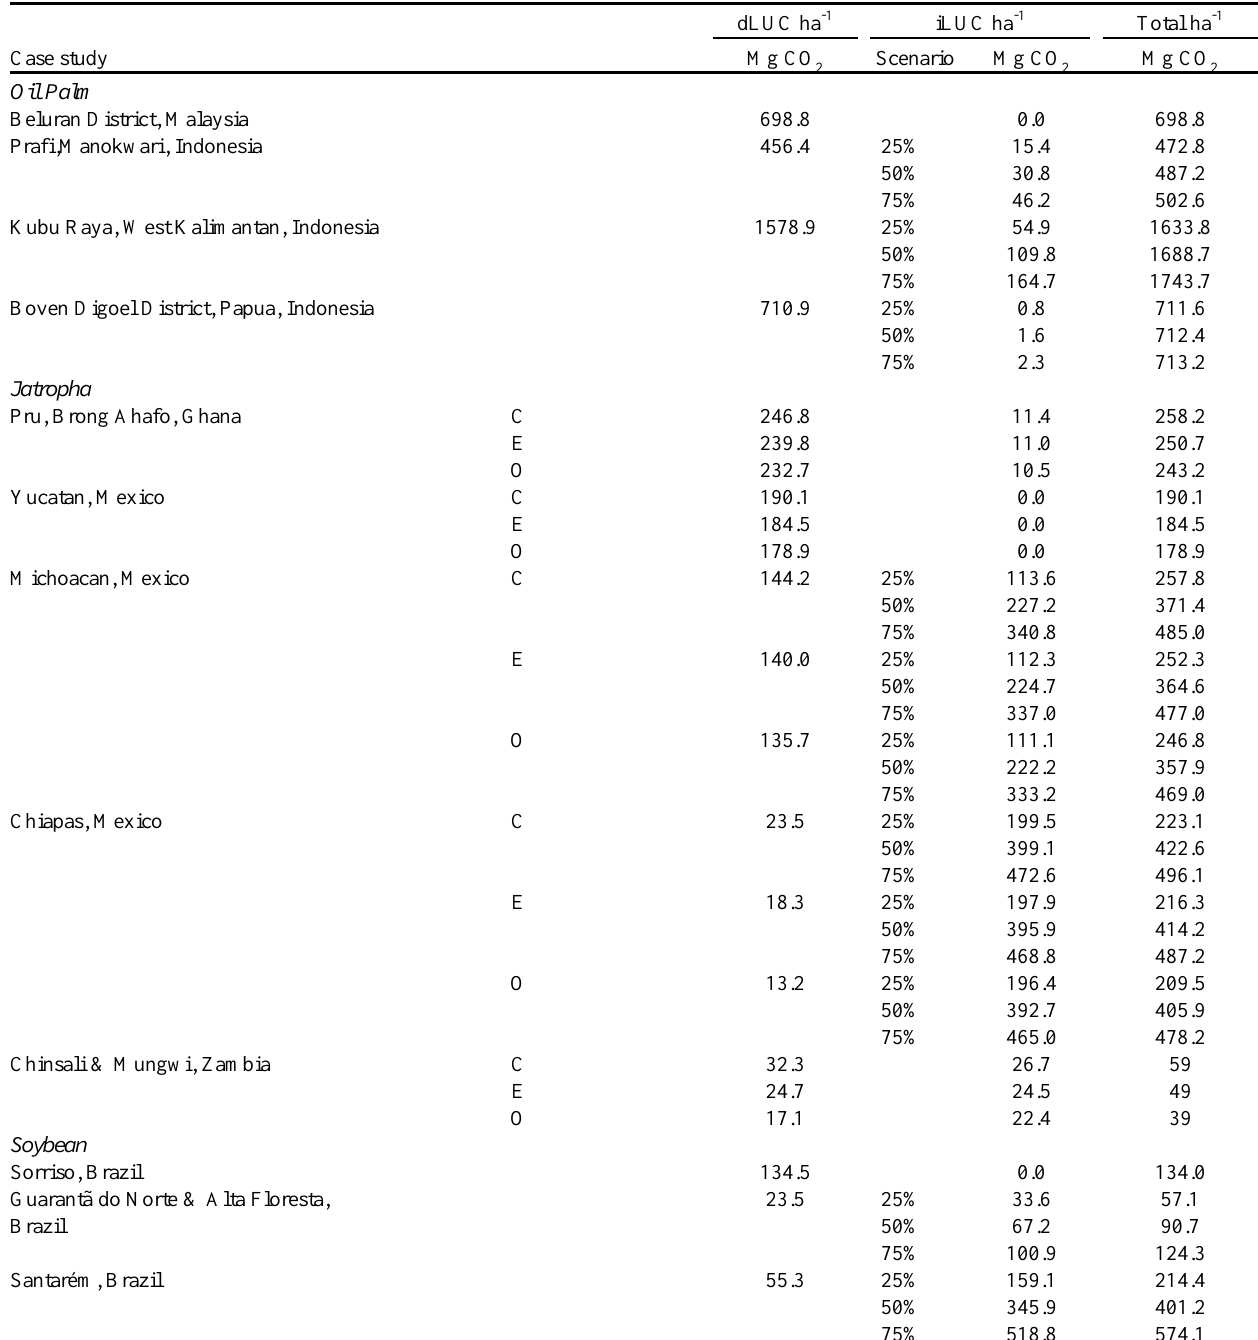
Table 2. Carbon debt due to direct (dLUC) and indirect land-use change (iLUC) expressed in terms of both carbon and CO